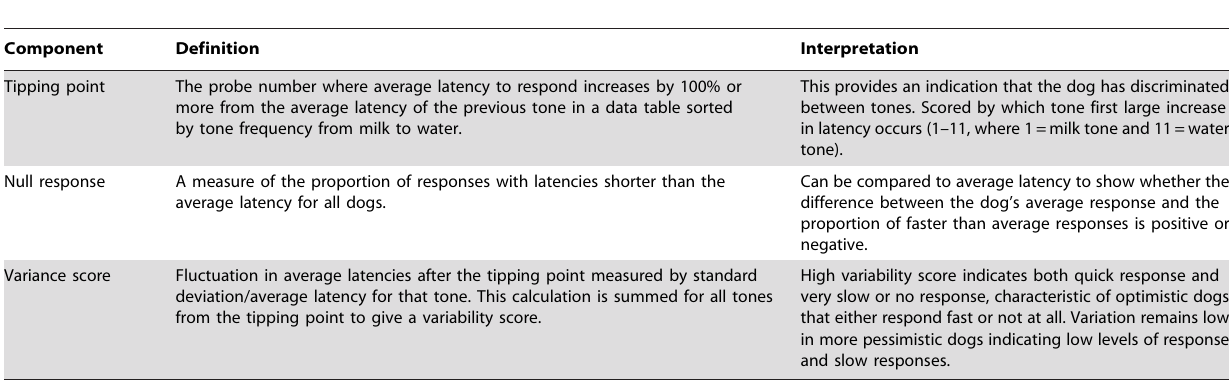
Table 4. A description of the mathematical model used to interpret latencies.